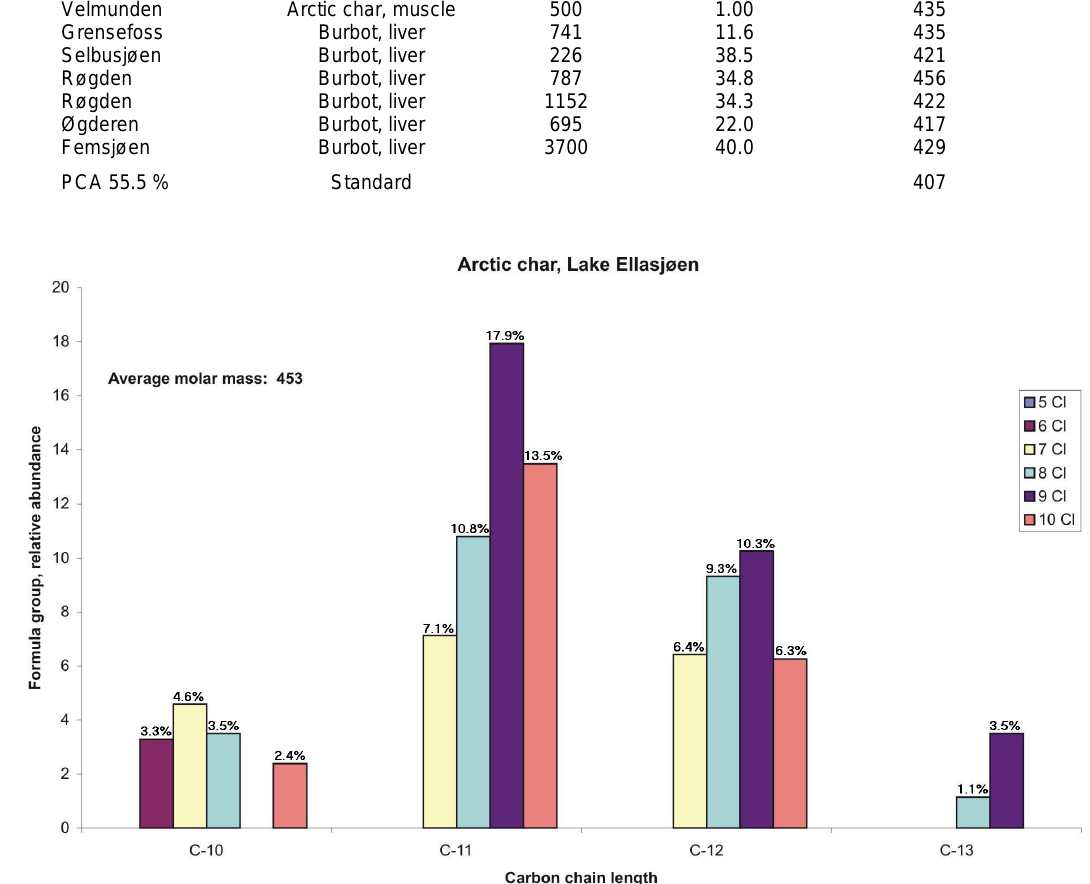
FIGURE 1. sPCA pattern in the Arctic char sample from Lake